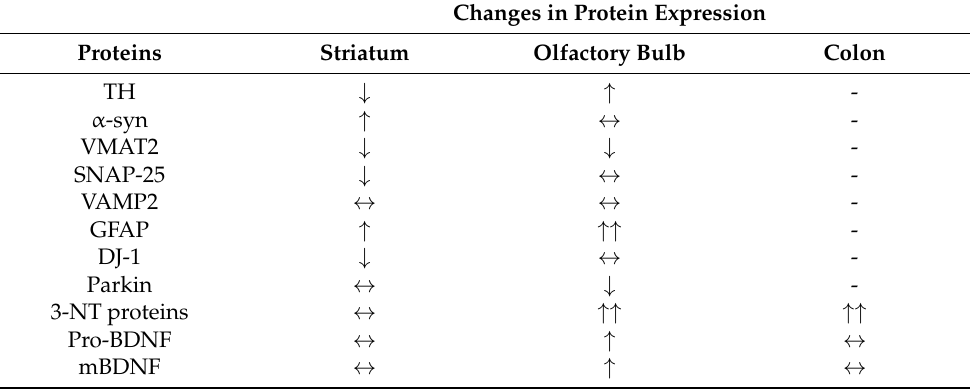
Table 1. Summary of the proteins examined by Western blot. Downwards ( ↓ ) and upwards ( ↑ ) arrows indicate the direction of “significance”, left-right arrow ( ↔ ) refers to “no significance”, and dash (-) refers to “not